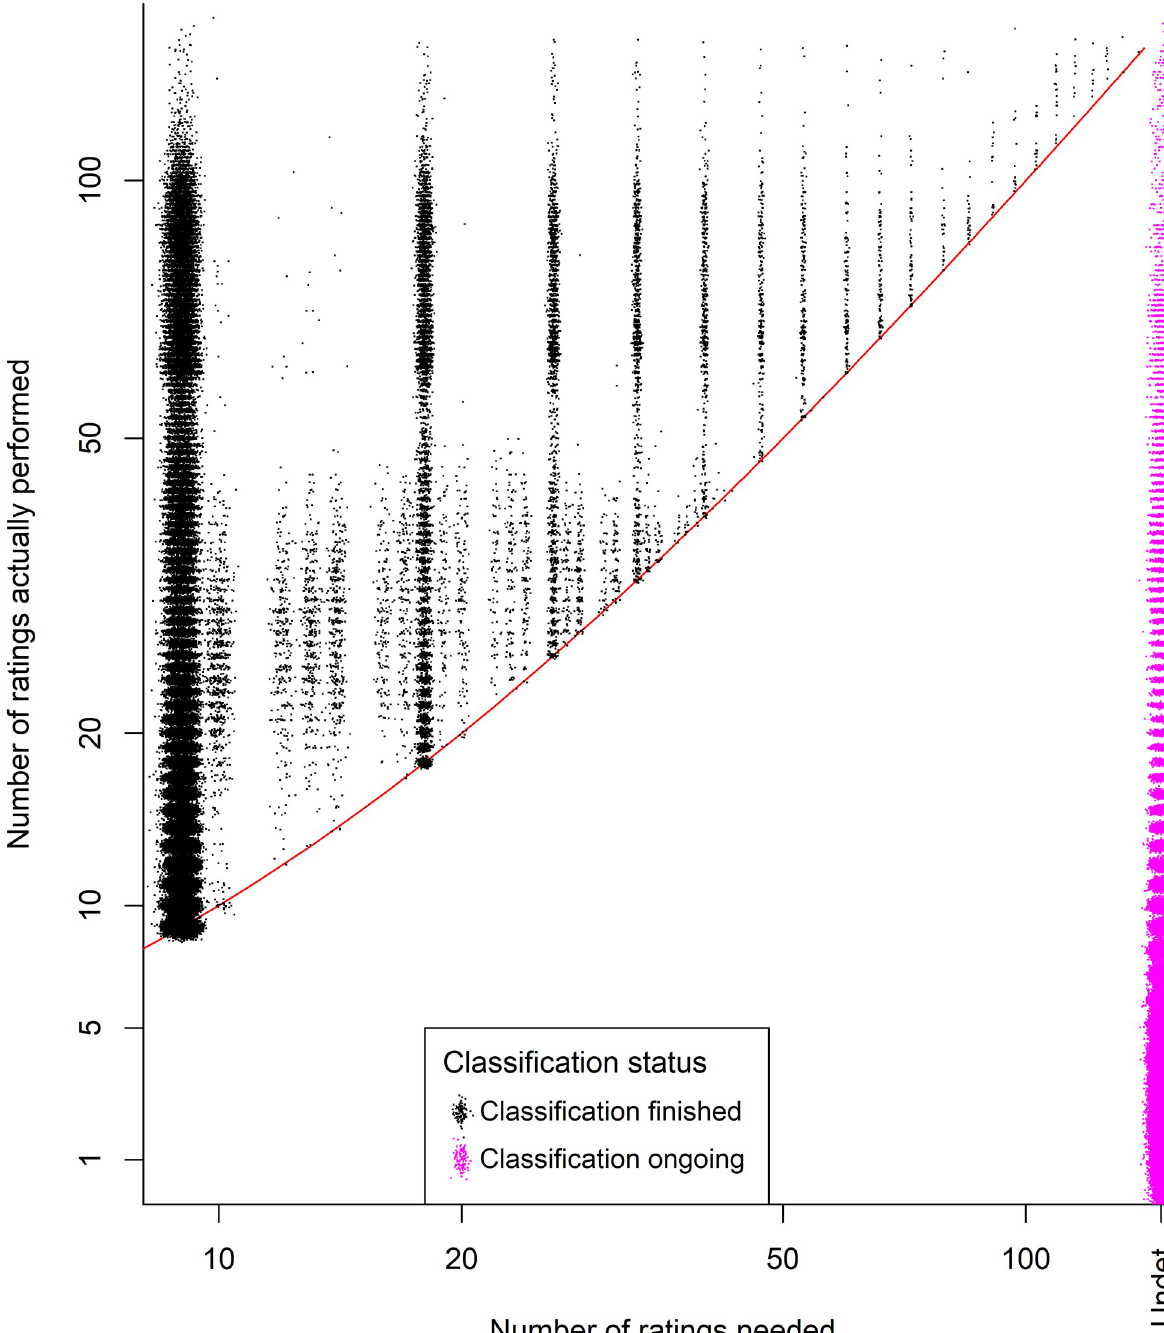
Fig 4. An illustration of the distributions of how many ratings were needed to classify an image versus how many were actually performed. The red line is a 1:1 line showing the number of ratings needed to classify a particular image (it appears slightly curved due to the modified log scale on the y-axis). The distance a black point falls above this line indicates how many unnecessary ratings were performed; some points fall slightly below this line because the points were jittered for clarity. The pink points indicate images that had not yet been classified at the end of the Cropland Capture campaign, thus it is undetermined (Undet.) how many ratings would have been required. Five images with hundreds of ratings each are omitted from this figure.